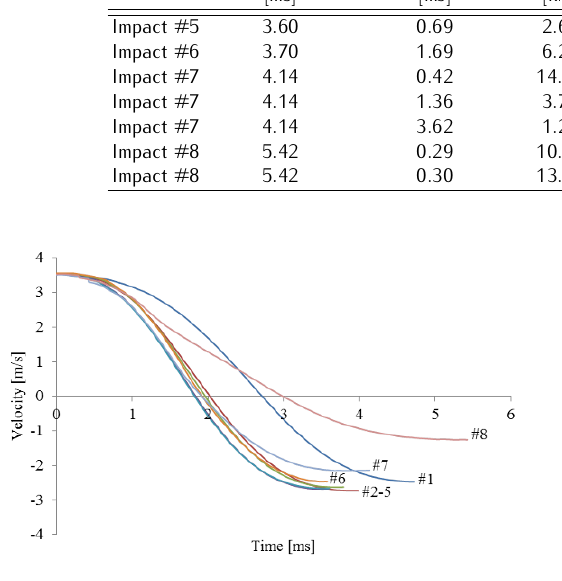
Figure 8. Velocity-time records of repeatedly impacted panels. In Figure 5, stiffness increases with the maximum force [6].